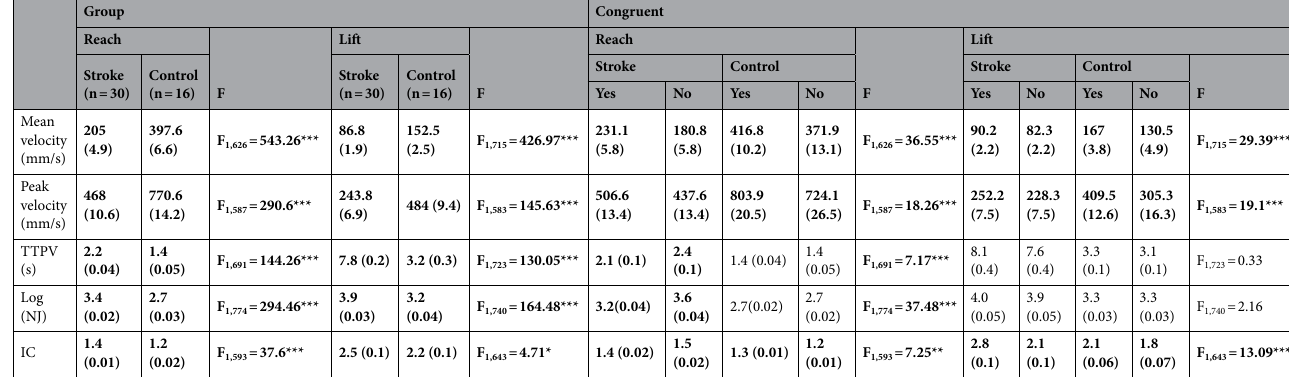
Table 3. Mean values of kinematic variables: group and lateralization effects. Summary of the results. Group: lists the mean values (SE); bolded values denote a significant difference between the groups. Congruent: lists the mean values (SE); Yes—the examined hand was the dominant one; No—the examined hand was the non-dominant one. Asterisks denote the p value: * p ≤ 0.05, ** p ≤ 0.01, *** p ≤ 0.001. mm Millimeters, s Seconds, TTPV Time to-peak-velocity, NJ Normalized Jerk, IC Index of